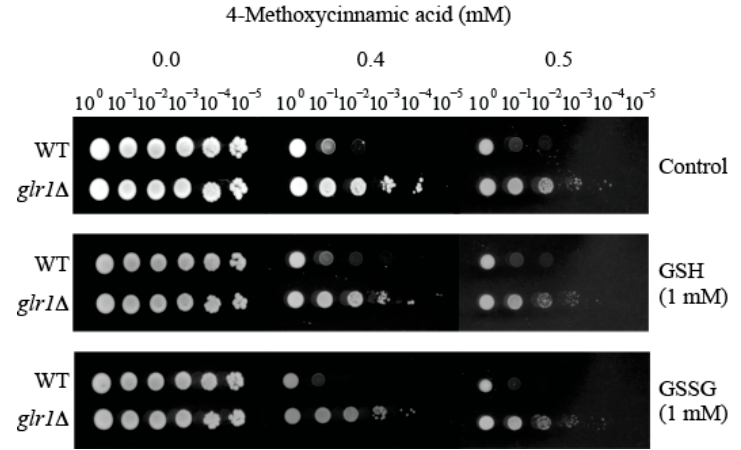
Figure 3. Glutathione supplementation test. The tolerance of S. cerevisiae glutathione reductase mutant ( glr1 Δ ) to 4-methoxycinnamic acid was not abolished by supplementation of reduced (GSH) or oxidized (GSSG) glutathione, indicating glutathione limitation was not the determinant of glr1 Δ hyper-tolerance to 4-methoxycinnamic acid.